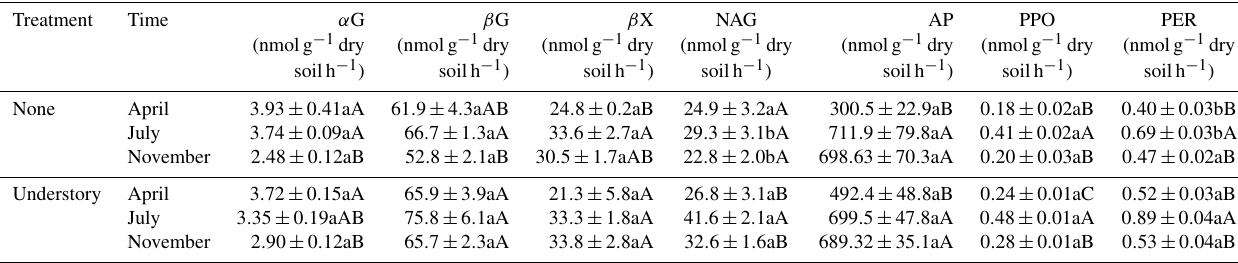
Table A7. Temporal variation in soil potential enzyme